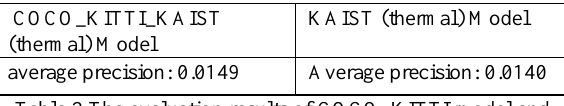
Table 2 The evaluation results of COCO_KITTI model and KITTI model.